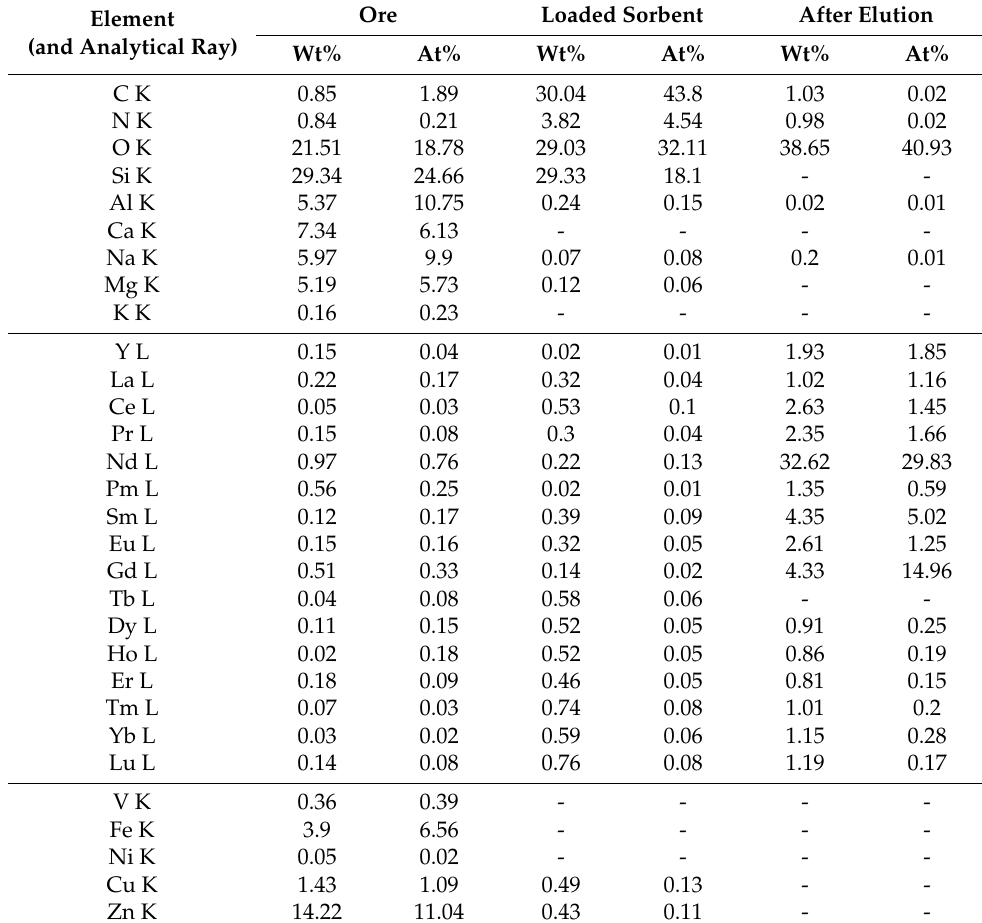
Table 5. Comparison of the composition of unpurified REEs ore, metal-loaded mesoporous compos- ite functionalized sorbent, and REE oxide (after oxalic acid precipitation and calcination) —semi- quantitative EDX analysis. Element (and Analytical Ray)